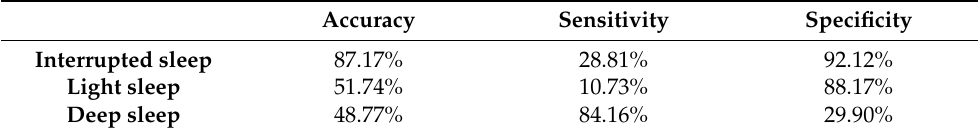
Table 2. Accuracy, sensitivity, and specificity of the Zulu sleep-depth scoring versus polysomnography.